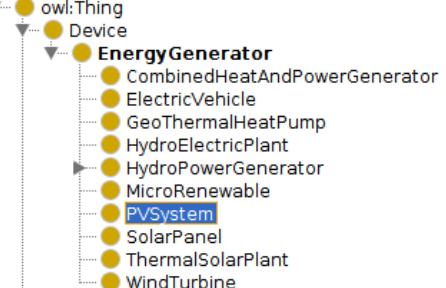
Figure 14. Protegé view of PVSystem in DABGEO. Listing 1. JSON-LD representation of the photo-voltaic